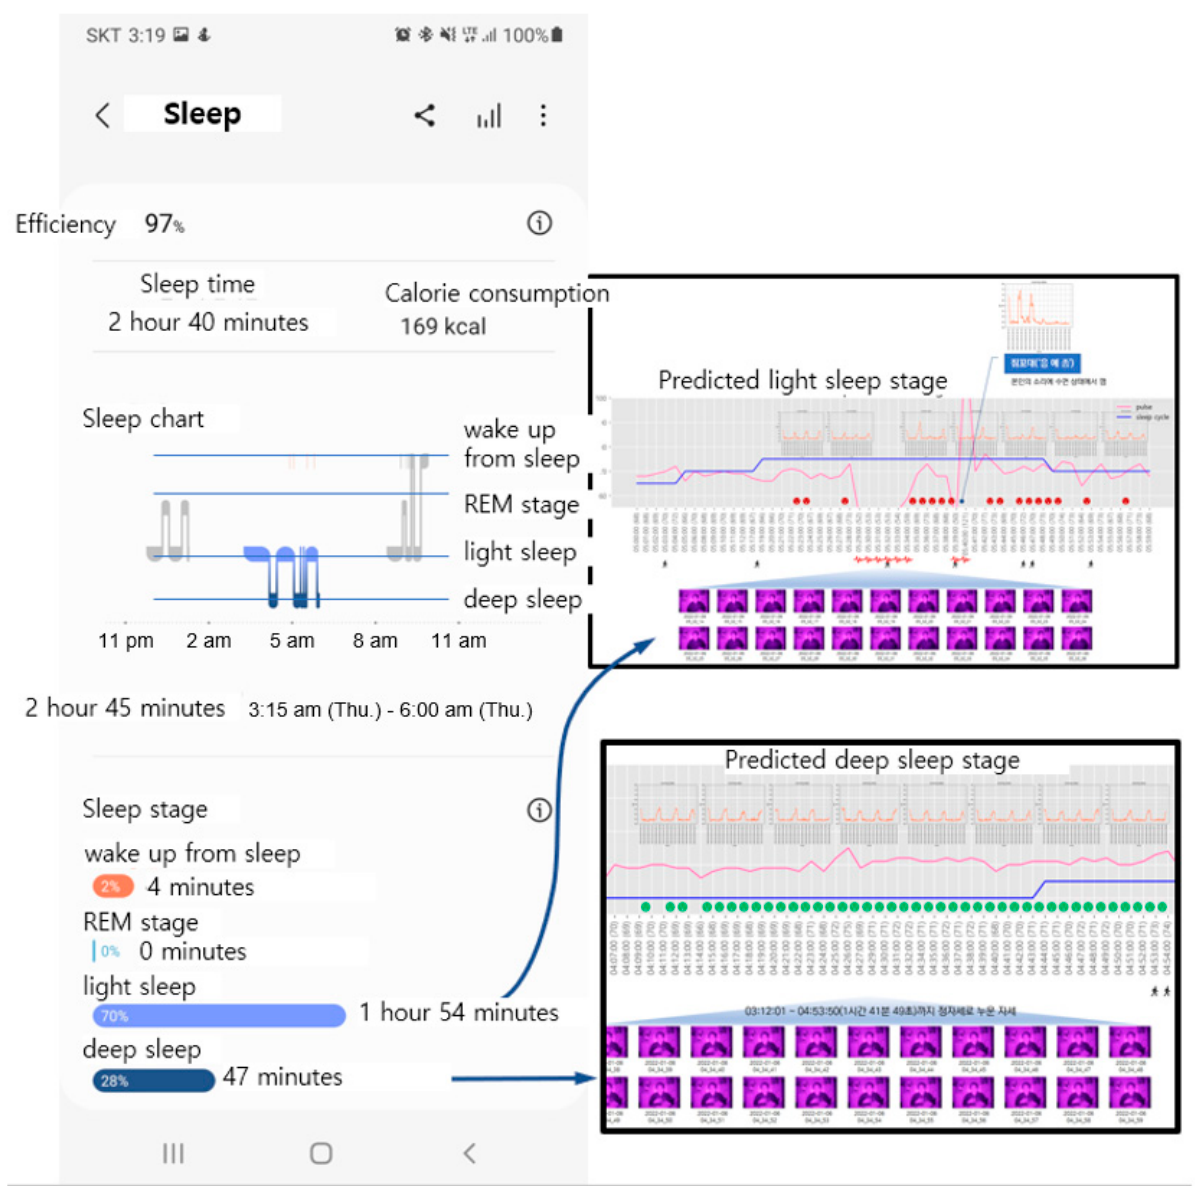
Figure 23. Comparison of the measurement results of the application and